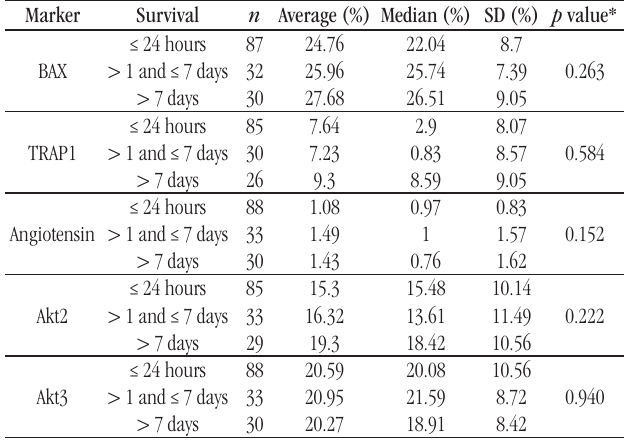
taBLE 2 − Relationship between survival time (days or hours) and tissue immunostaining of the biomarkers in percentage of immunopositive area by HPF Marker Survival